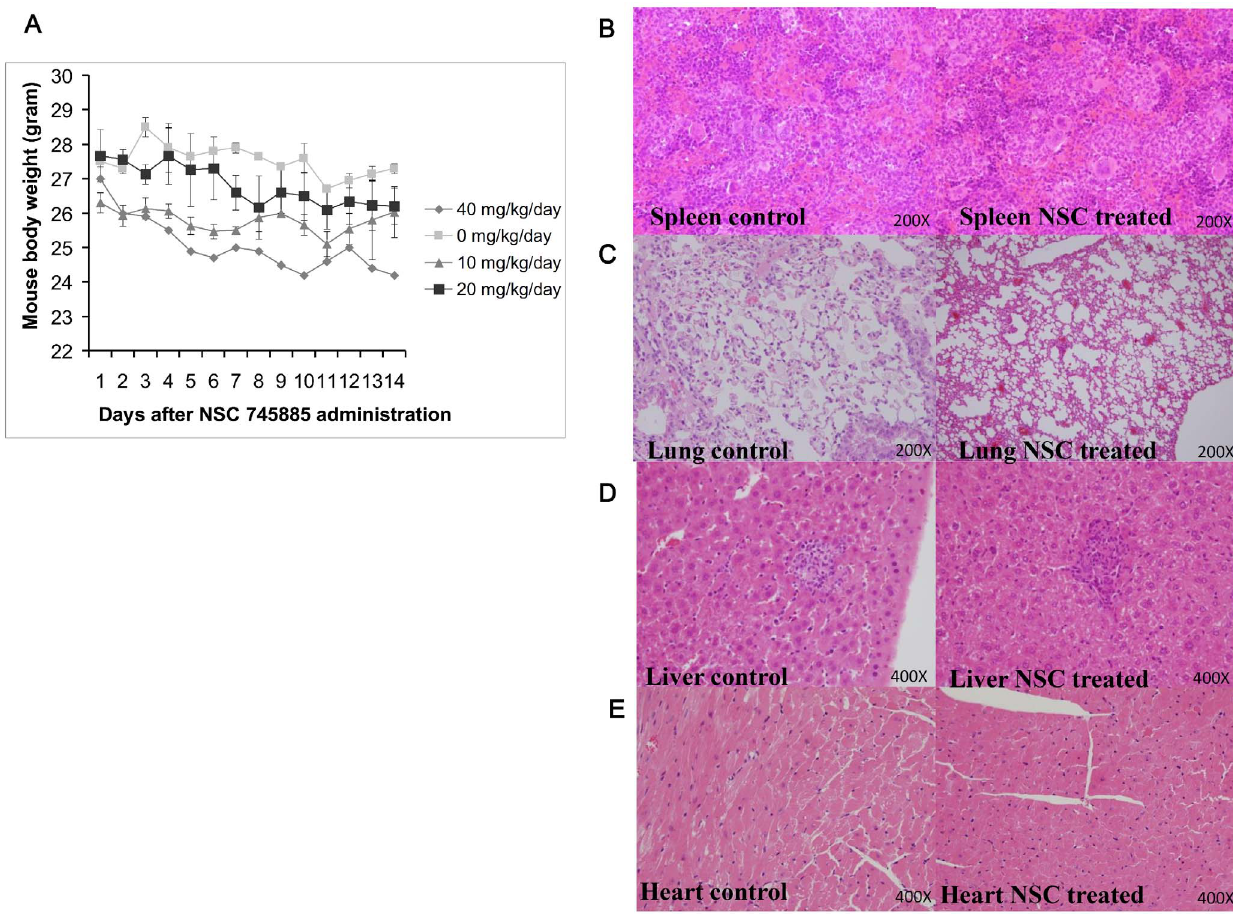
Figure 8. The effects of NSC745885 treatment in the experimental mice. (A) NOD/SCID mice were treated with PBS or indicated daily dosages of NSC745885, and the body weights of these mice were measured. The influence of NSC745885 treatment on the organs of the experimental mice was assessed using a histological assay and HE staining on Day 14. No obvious differences existed in the (B) spleen, (C) lung, (D) liver, or (E) heart of PBS-treated and NSC745885-treated